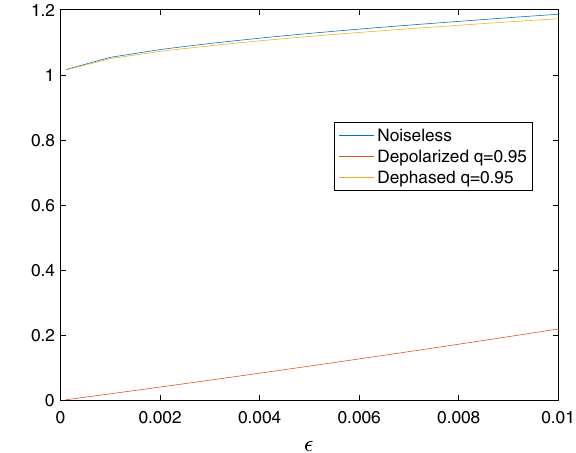
FIG. 9. Plot of ε -hypothesis-testing upper bound on conference key rate for a single copy of the Φ GHZ 3 state, for noiseless, dephased, and depolarized cases.